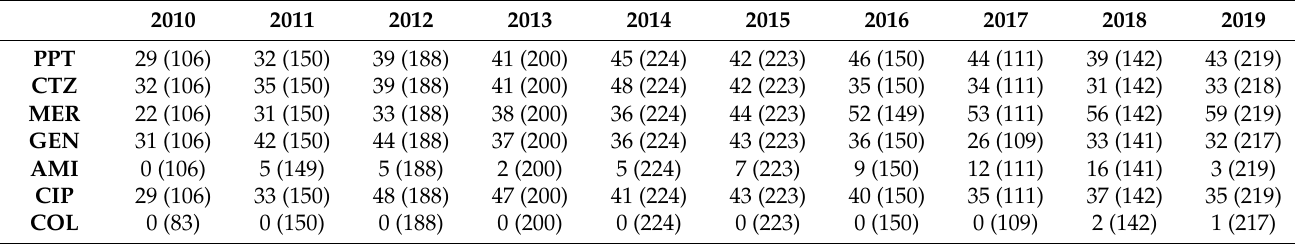
Legend: Resistance percentages (total number of isolates tested). Table 10. Resistance of Pseudomonas aeruginosa to antibiotics at the Department of Anesthesiology and Intensive Care Medicine in 2010–2019.